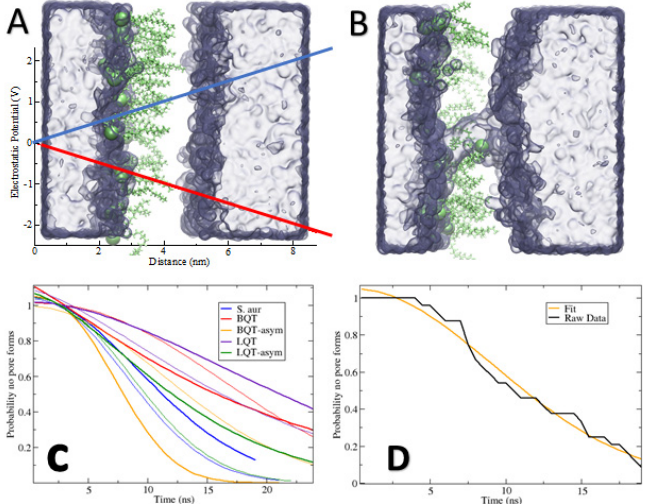
Figure 7. ( A , B ) Snapshots of an asymmetric BQT membrane system before and after pore formation due to the applied electric field. Water is a blue surface, and BQT is lime green, while the S. aureus lipids are not shown. The blue and red lines in A show the electric field strength across the membrane. ( C ) Probability that a pore will not form at a given time. The thin lines refer to systems with a negative applied field. Probabilities were from 24 replicates for each system and observing the time it takes for a pore to form, after fitting to a stretched exponential function. ( D ) Example showing the raw data and the stretched exponential fit for the S. aureus system.